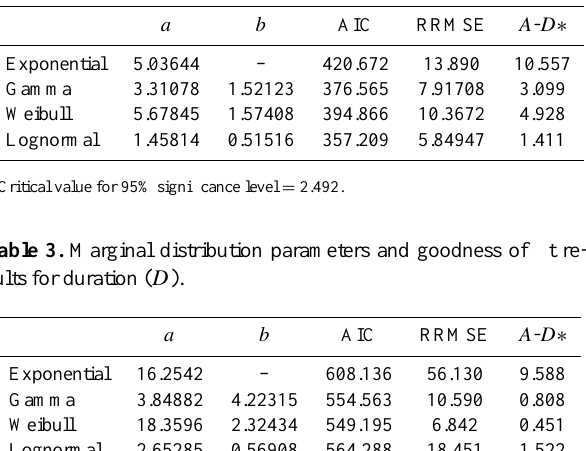
* Critical value for 95% significance level = 2.492.